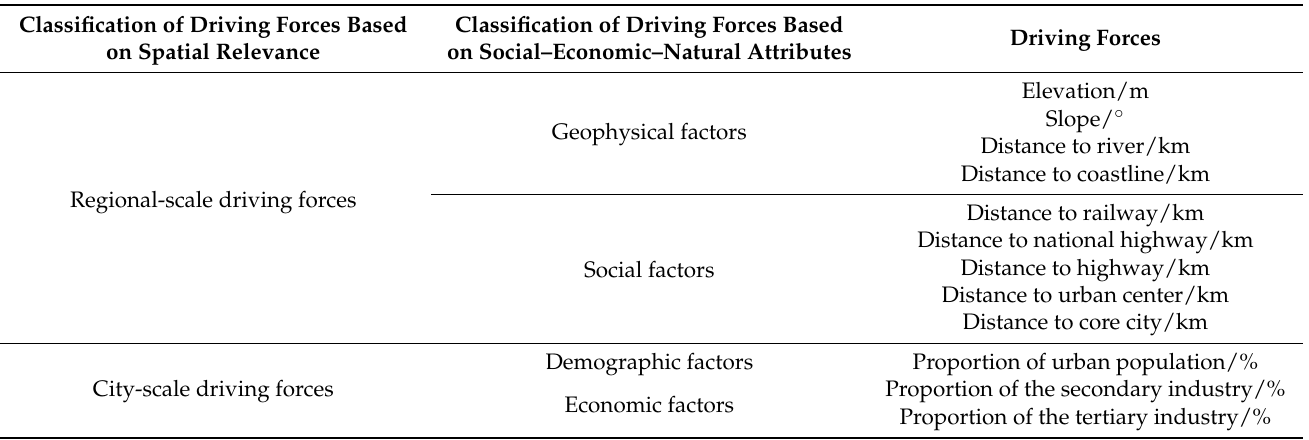
Table 1. Factors Driving the Spatial Evolution of Construction Land in the Beijing–Tianjin–Hebei (BTH) and Yangtze River Delta (YRD) Urban